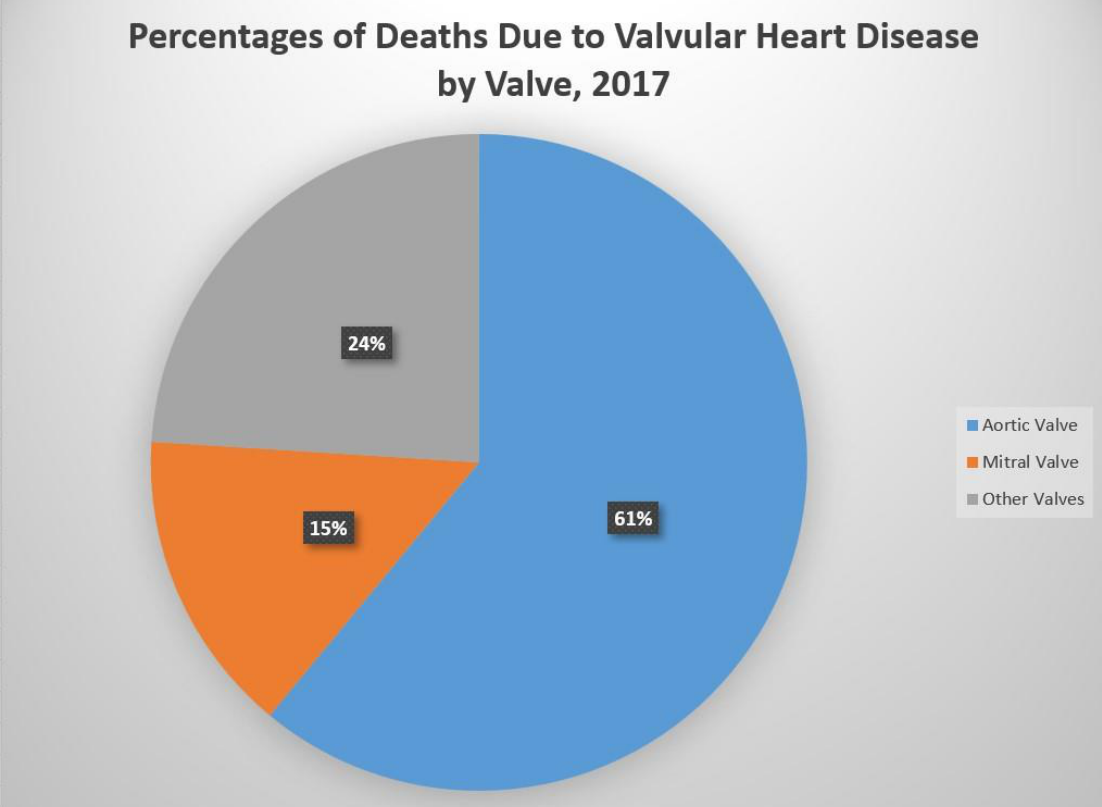
Figure 1. Percentages of deaths due to valvular heart disease, by valve, 2017 — data obtained from CDC, Atlanta, GA, USA. Available online: https://www.cdc.gov/heartdisease/valvular_disease.htm (Accessed on 25 April 2022).